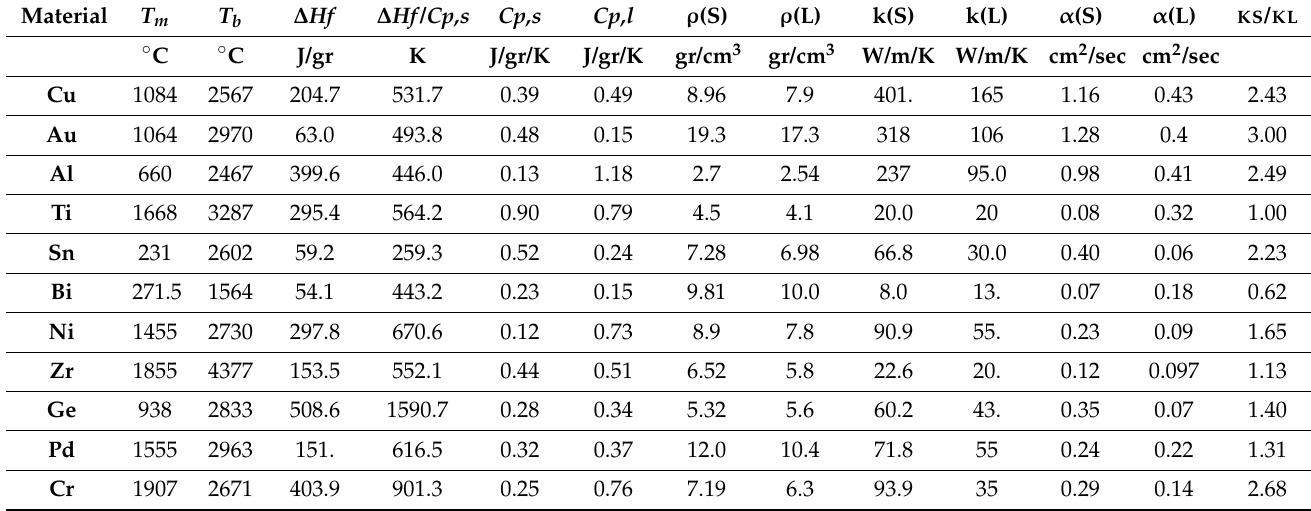
Table A3. Thermophysical parameters of several materials of interest for use in evaluation of T L . Tm is the melting temperature, Tb is the boiling temperature, ∆ Hf is the heat of fusion, Cp,s and Cp,l are the heat capacity of the solid and the liquid state respectively , ρ (s) and ρ (l) are the densities in the solid and liquid states respectively, k(s) and k(l) are the thermal conductivity of the solid and the liquid states respectively, α (S) and α (L) are the heat diffusion coefficients in the solid and liquid states respectively. Since the thermal parameters vary with temperature, we have chosen for simplification to use the values near the melting temperature for the molten state and values at room temperature for the solid materials. Clearly a more accurate calculation should consider the temperature dependence of the relevant thermophysical parameters.